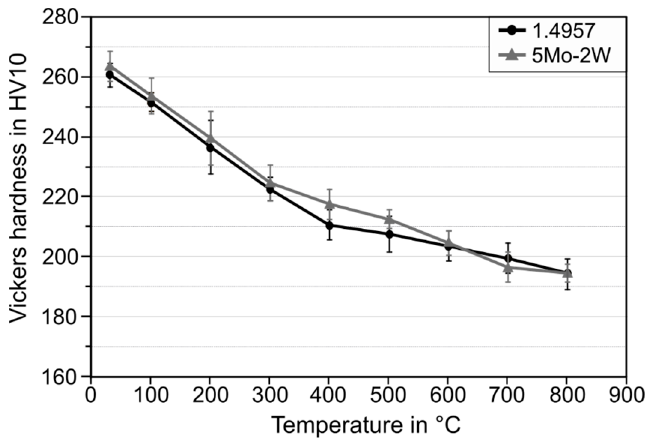
Figure 7. Hot hardness of the steel 1.4957 and 5Mo-2W in the aged condition.